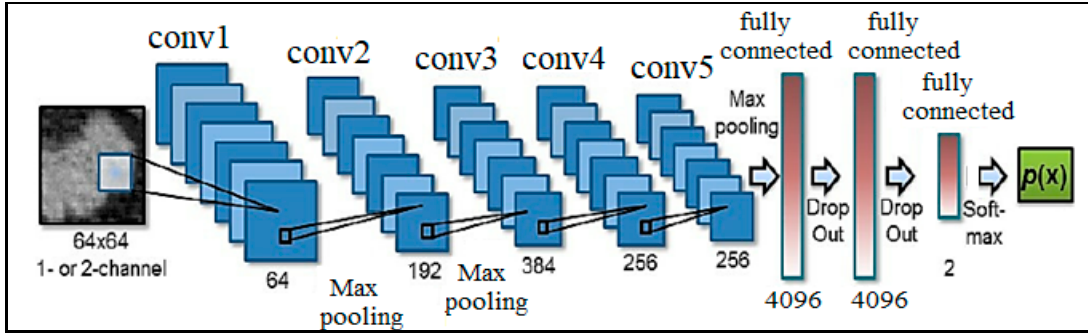
Figure 5. Basic CNN Architecture [9].